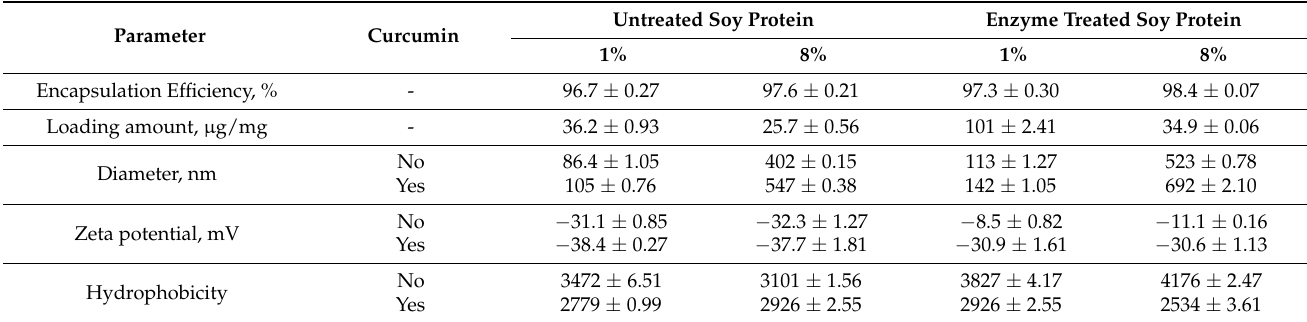
Table 6. Properties of soy protein nanoparticles (prepared using 1 or 8% solution) before and after treating with glutaminase. Reprinted with permission from ref. [107]. Copyright 2018